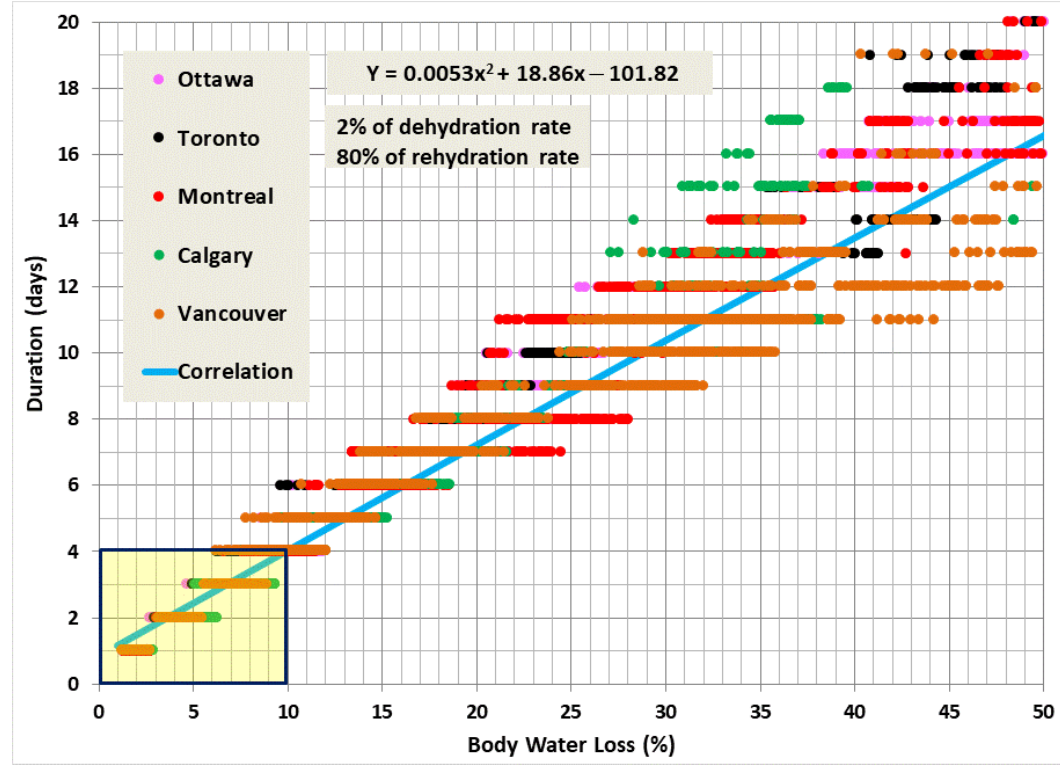
Figure 8. Duration of overheating events versus body water loss in LTCHs.